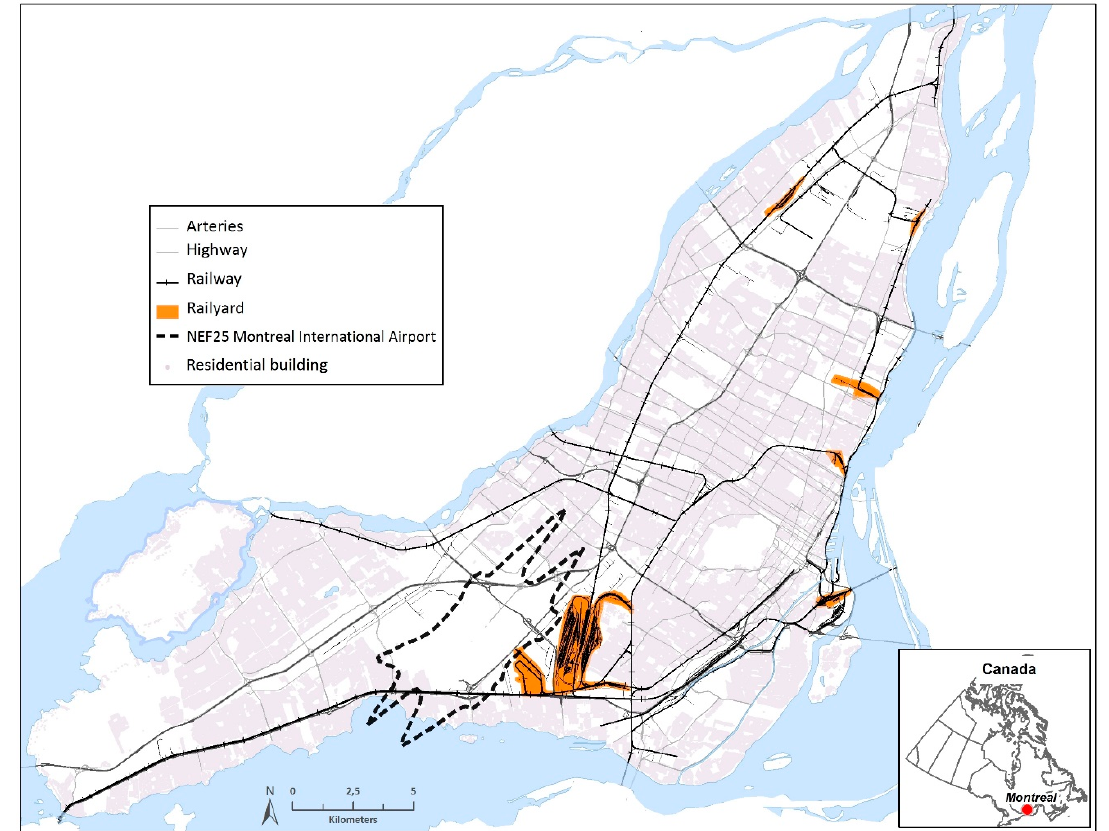
Figure 1. Map of the study area, the island of Montreal, with potential transportation noise sources.